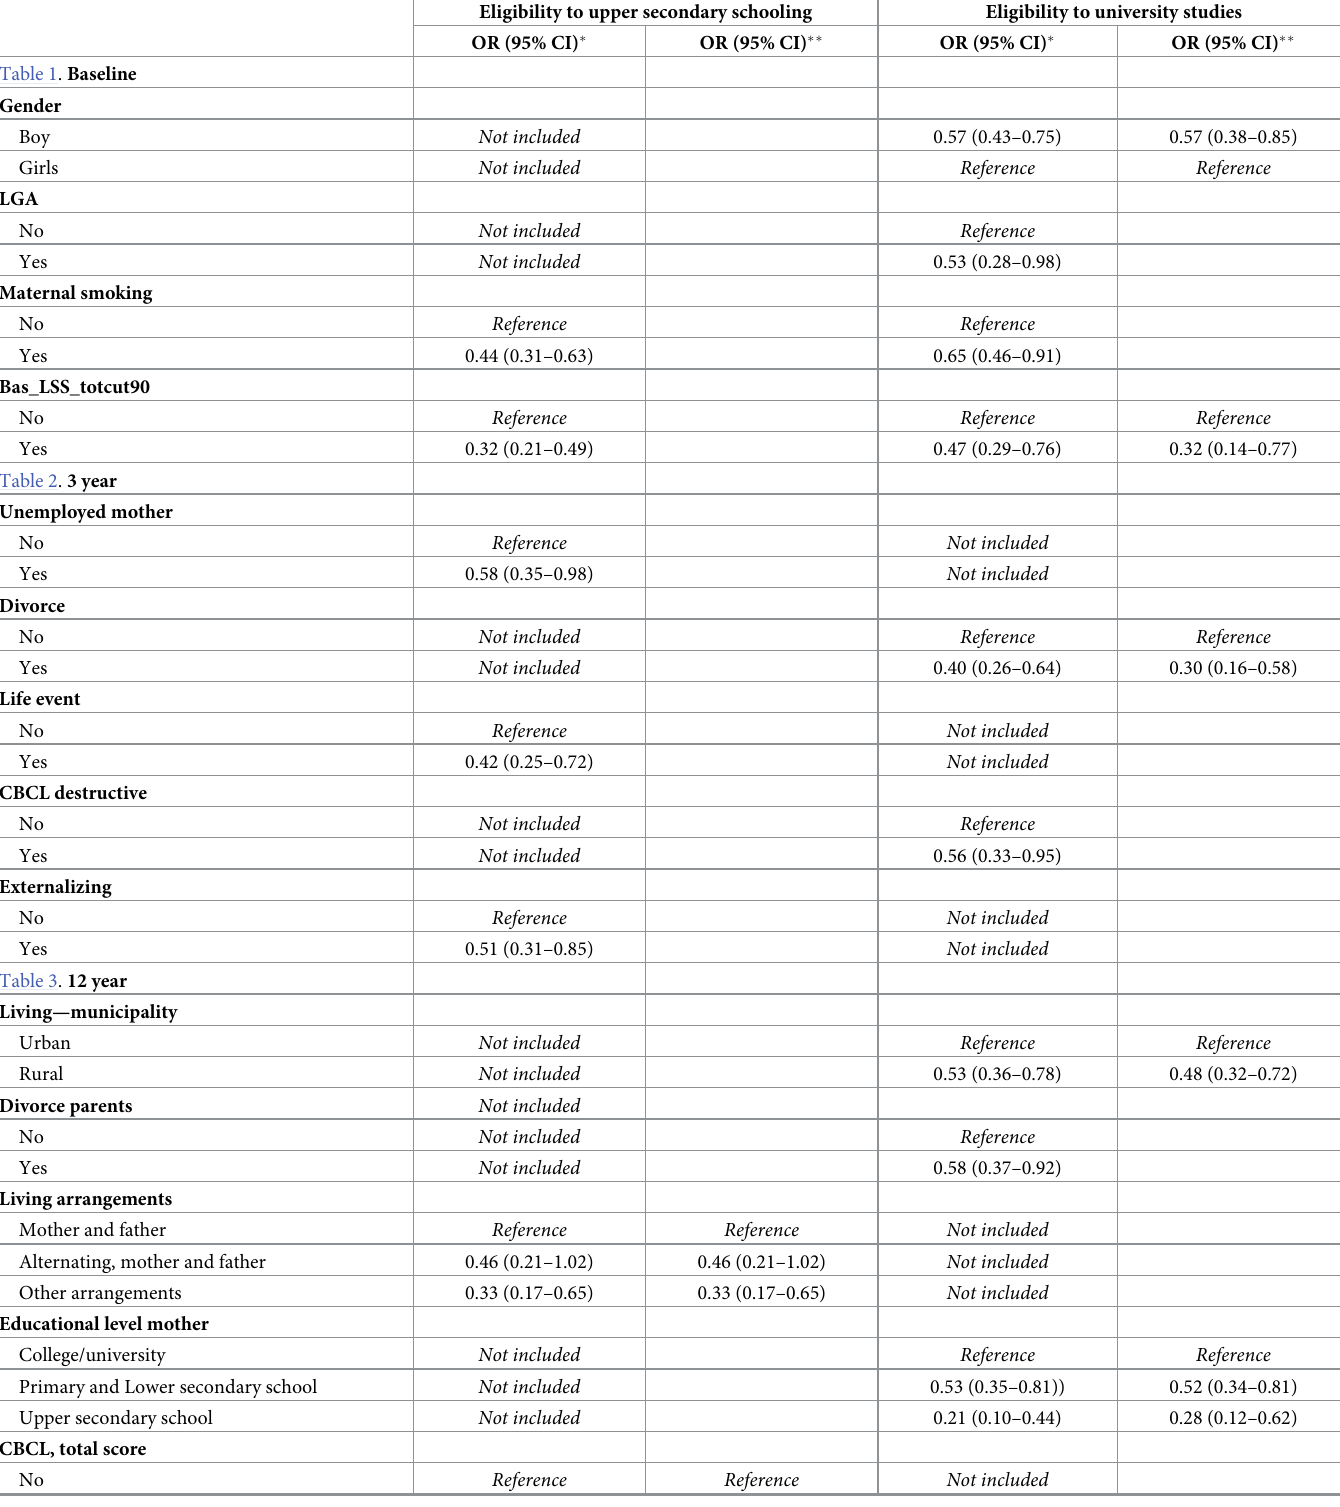
Table 4. Multiple logistic regression analyses on the eligibility to upper secondary school and